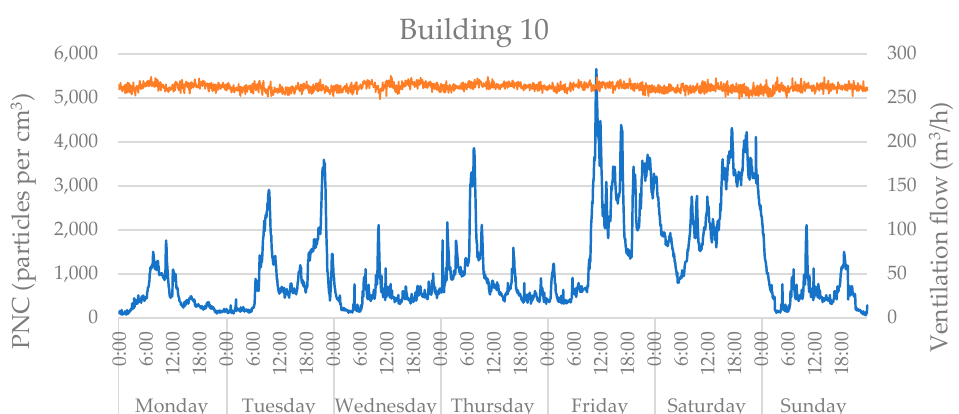
Figure 9. The NP number concentration (blue line) and the ventilation flow (orange line) in Building 10 during the heating season. The NP concentrations and the ventilation flow were measured in five-minute intervals.